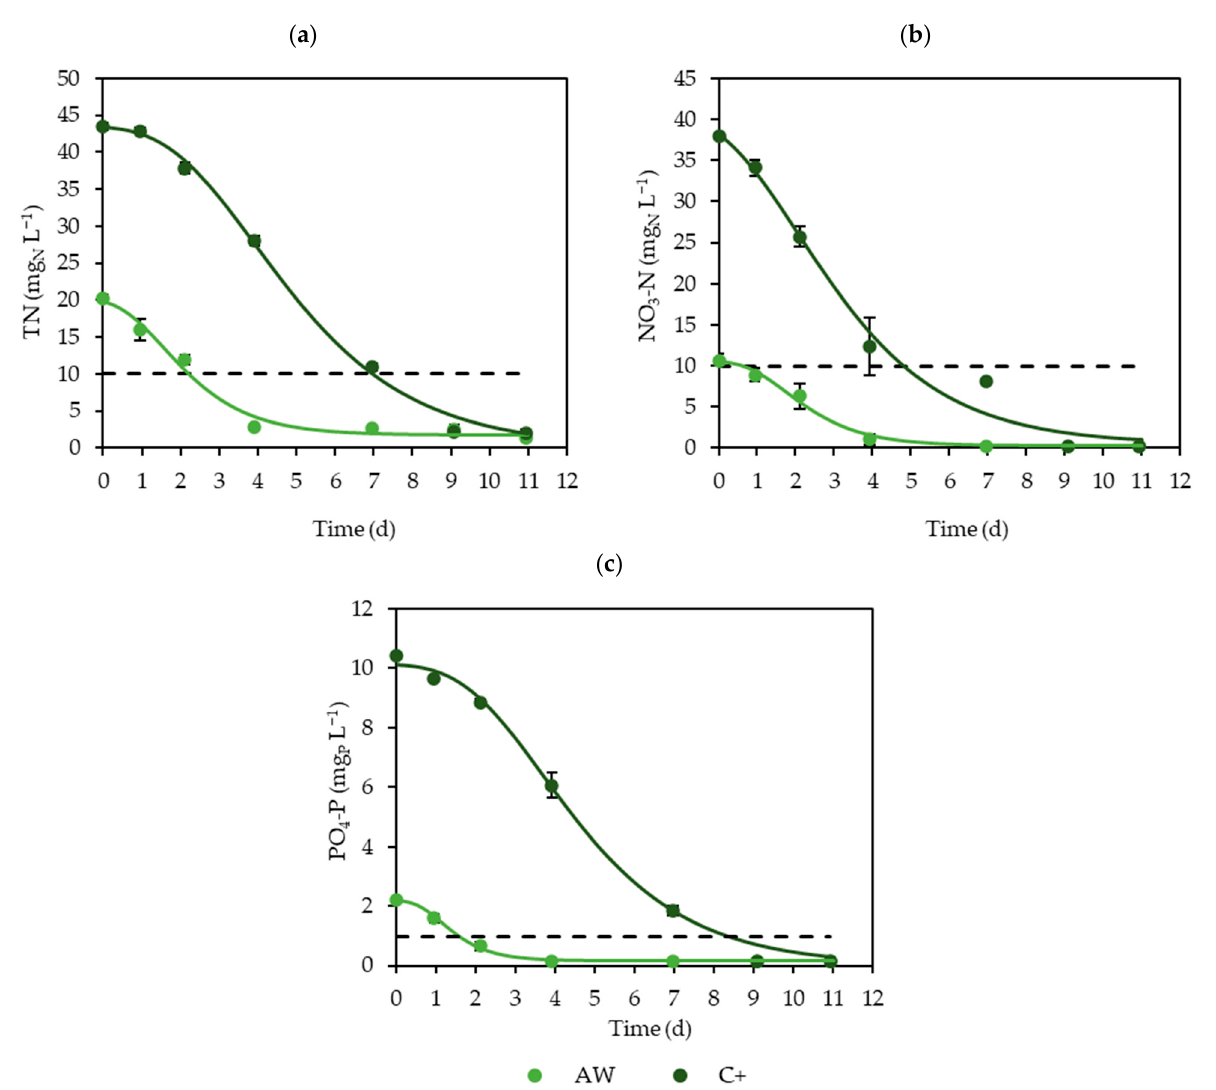
Figure 3. Experimental data and achieved modified Gompertz models (solid lines) for: ( a ) total nitrogen (TN); ( b ) nitrate-nitrogen (NO 3 -N); and ( c ) phosphate-phosphorus (PO 4 -P) concentrations in AW and C+ assays. The lowest EU legislation limits for treated urban wastewater discharged into aquatic bodies subject to eutrophication (10 mg N L − 1 and 1 mg P L − 1 ) are represented by horizontal dashed lines.